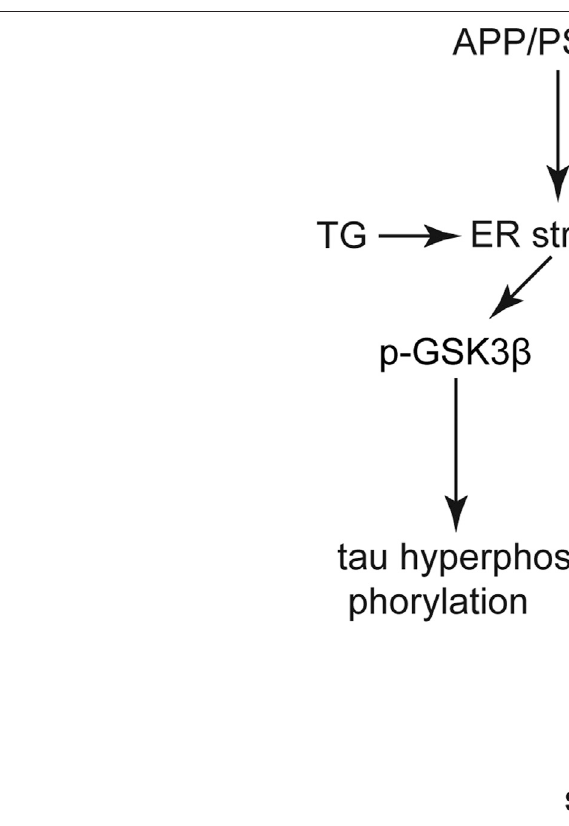
Frontiers in Pharmacology |